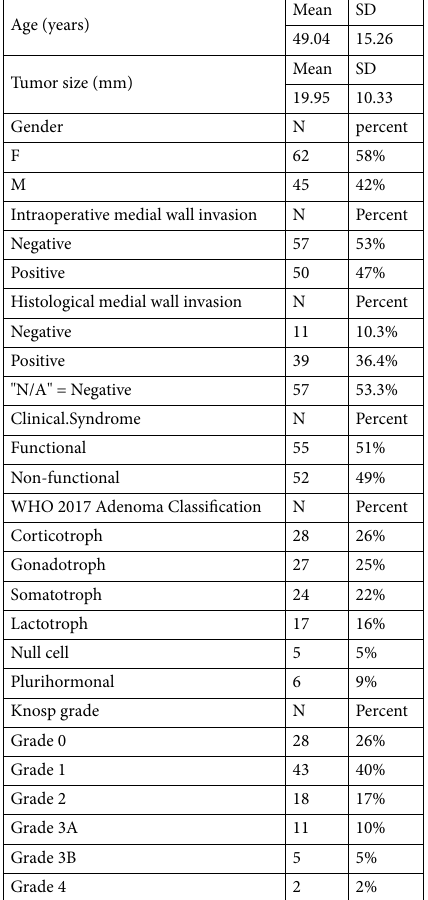
Table 1. Patient Cohort n=107. Cohort of 107 consecutive primary pituitary adenoma patients. Variables include age, tumor size, gender, intraoperative evaluation of medial wall invasion, histological evaluation of medial wall invasion, WHO 2017 Adenoma classification and Knosp grade. Categorical variables are reported as number and percentage, and continuous variables are reported as mean ± standard deviation.